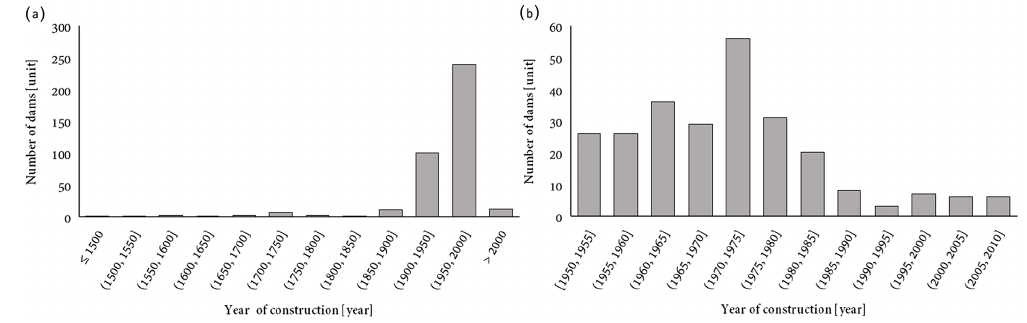
Figure 4. Construction year of the dams in Germany (a) and a subplot for the period between 1950–2015 (b) .